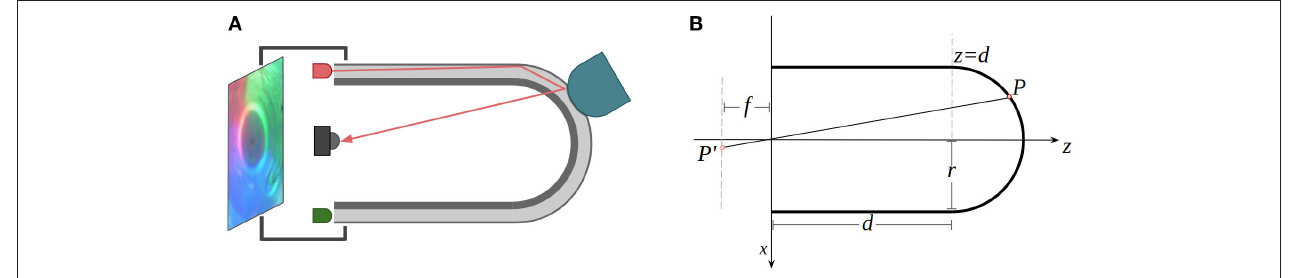
FIGURE 2 | (A) The working principle of the proposed GelTip sensor. The three-layer tactile membrane (rigid body, elastomer, and paint coating) is shown in gray. The light rays emitted by the LEDs travel through the elastomer. As one object, shown in yellow, presses the soft elastomer against the rigid body, an imprint is generated. The resulting image is captured by the camera sensor, placed in the core of the tactile sensor. An opaque shell, enclosing all the optical components, ensures the constant internal lighting of the elastomer surface. (B) Two-dimensional representation of the geometrical model of the GelTip sensor. The tactile membrane is modeled as a cylindrical surface and a semi-sphere. An optical sensor of a focal-length f is placed at the referential origin of the sensor, which projects a point on the surface of the sensor P into a point P ′ in the image plane. The sensor has a radius r , and its cylindrical body has a length d .